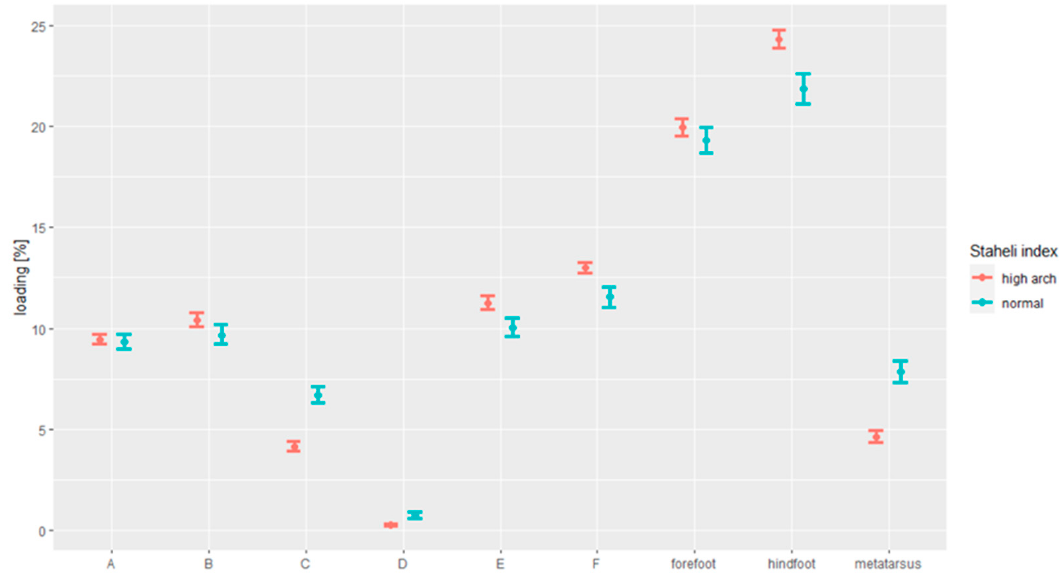
Figure 5. The dependence between the foot loading paradigm under the static conditions and Staheli